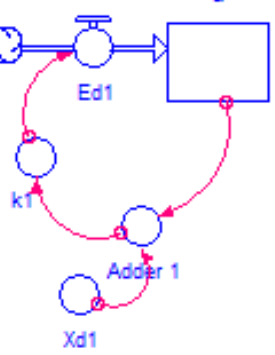
Figure 4. Forrester diagram for n = 1 variable state .